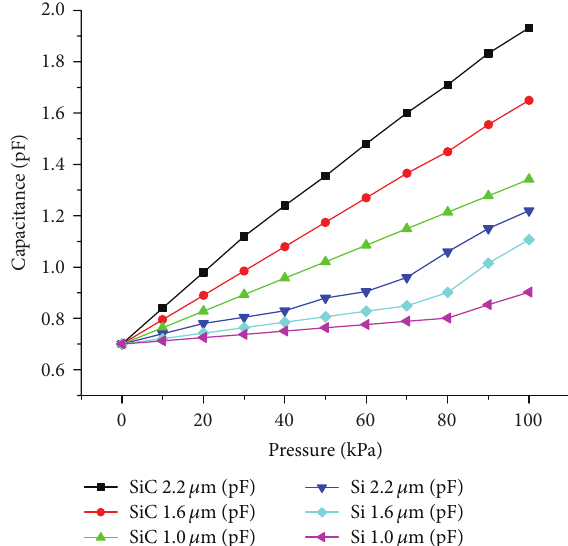
Figure 10: Comparison of capacitance versus pressure for 3C-SiC and Si with differential thicknesses of diaphragm.